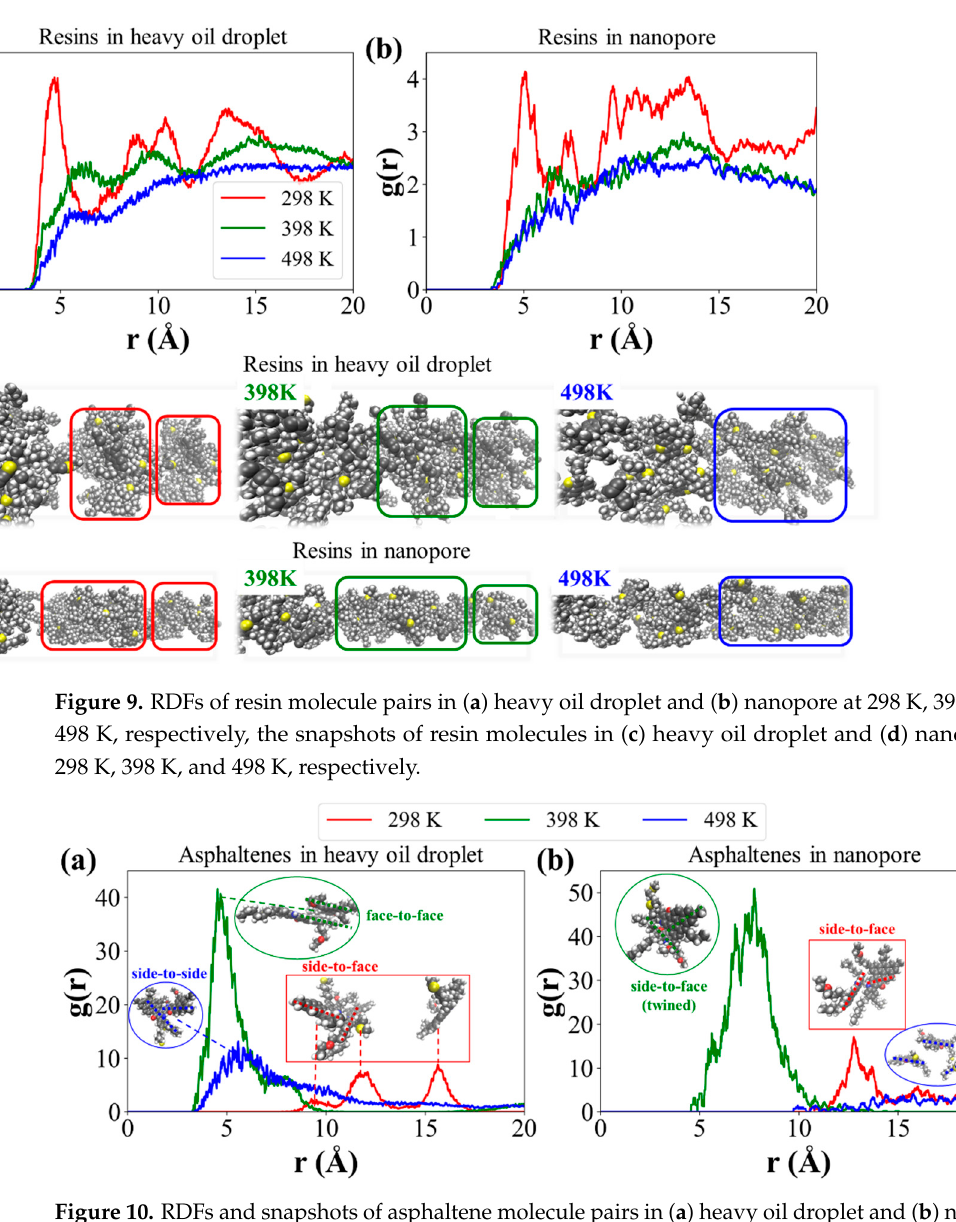
Figure 10. RDFs and snapshots of asphaltene molecule pairs in ( a ) heavy oil droplet and ( b ) nanopore at 298 K, 398 K, and 498 K, respectively.